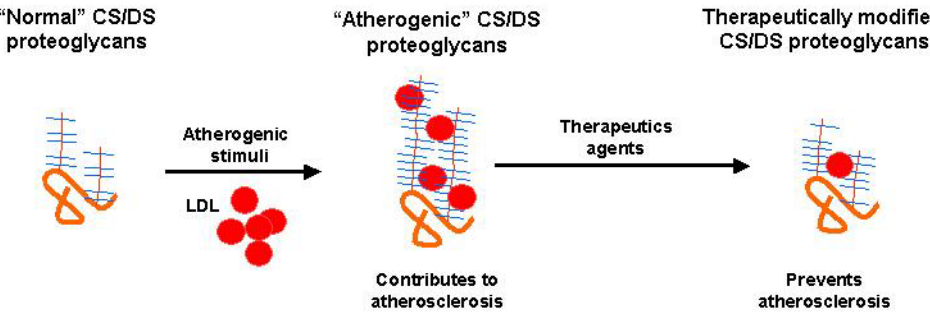
FIGURE 2 . Therapeutic modulation of CS/DS proteoglycan biochemical size and sulfation can reduce LDL binding and prevent atherosclerosis. The CS/DS proteoglycan biglycan consists of a core protein (orange), two GAG chains (red vertical extensions), which are sulfated (blue horizontal lines). Atherogenic growth factors such as PDGF and TGF- β 1 stimulate SMCs to synthesize proteoglycans, which have longer GAG chains and altered sulfation pattern leading to higher affinity and higher-capacity binding of CS/DS proteoglycans to LDL particles (red). Therapeutic agents may reduce either/or the GAG length and the sulfation pattern of GAG chains leading to reduced binding of CS/DS proteoglycans to